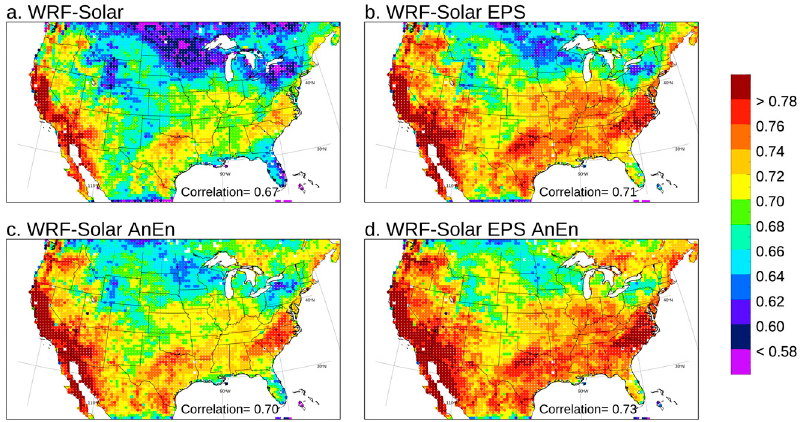
Figure A3. Pearson correlation computed for DNI over the year 2018 for the forecast lead times from +24 to +48 h. The value in the legend at the bottom of each panel indicates the correlation computed by pooling all the grid points and lead times together.